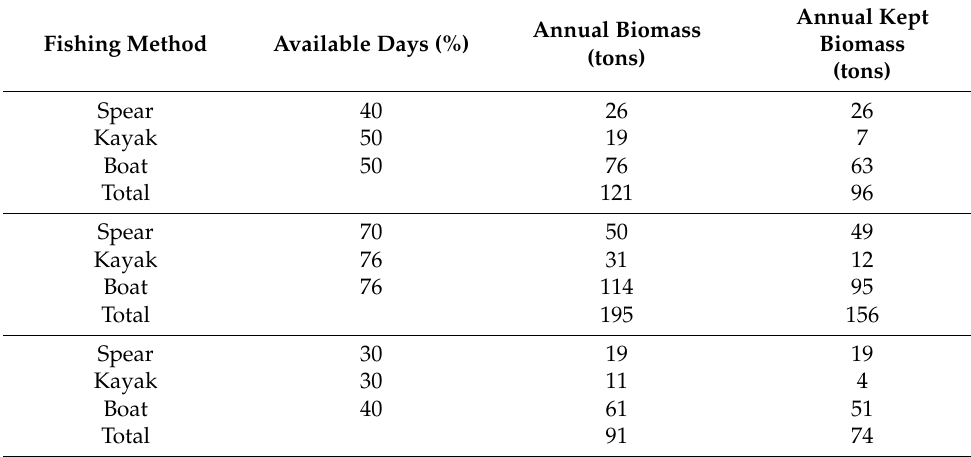
Table 3. Estimated annual biomass (tons) for recreation fishing at sea. Estimates are based on different estimations of the number of available fishing days for each fishing